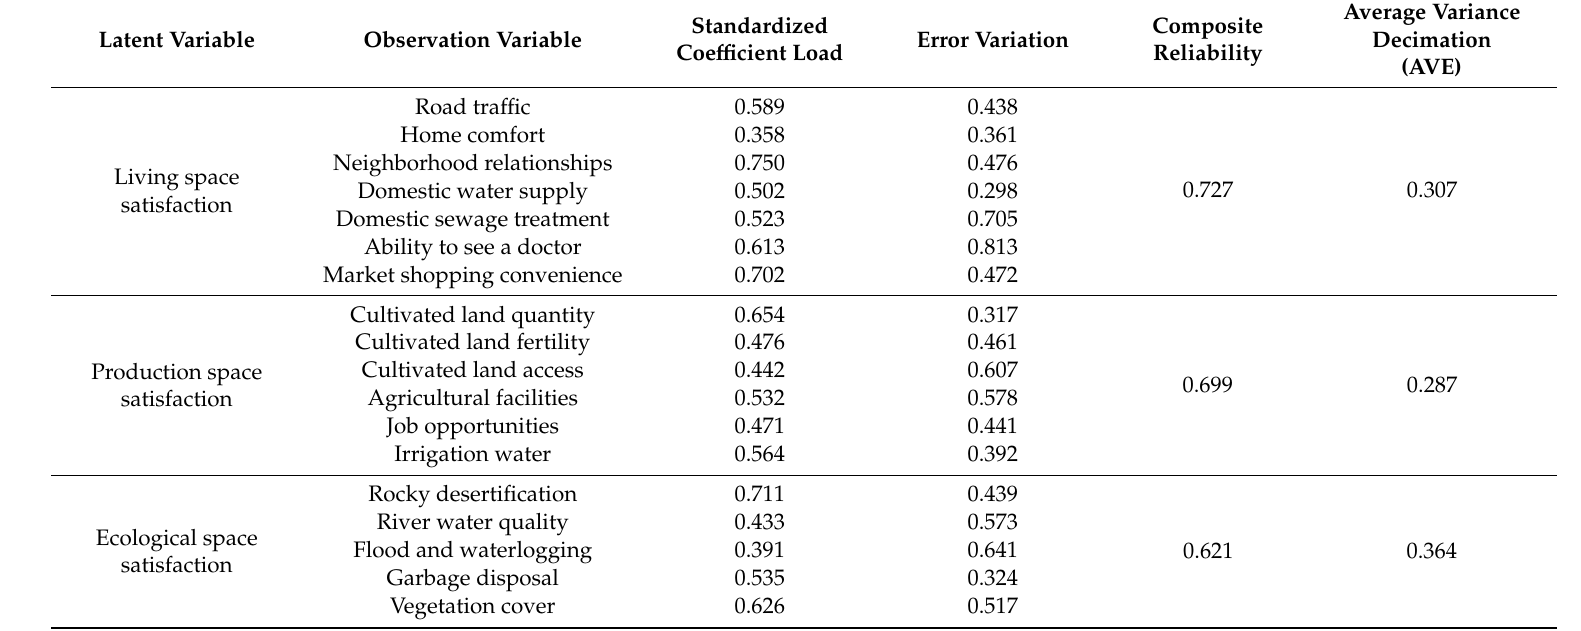
Table 4. Exploratory factor analysis of Ecological–Living–Productive